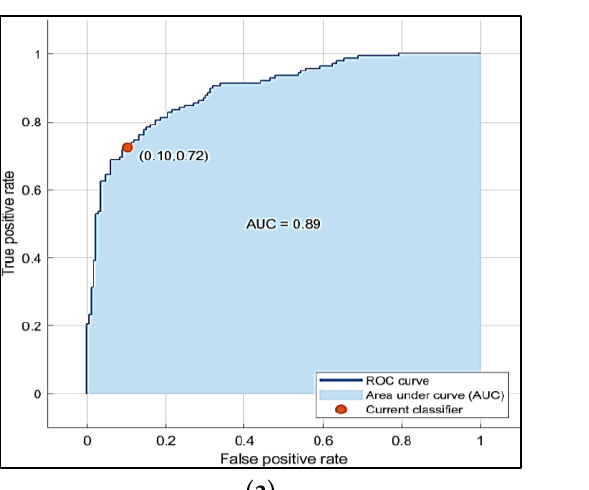
Figure 9. ( a ) ROC curve corresponding to class 0 ( b ) ROC curve corresponding to class 1 using AdaBoost.